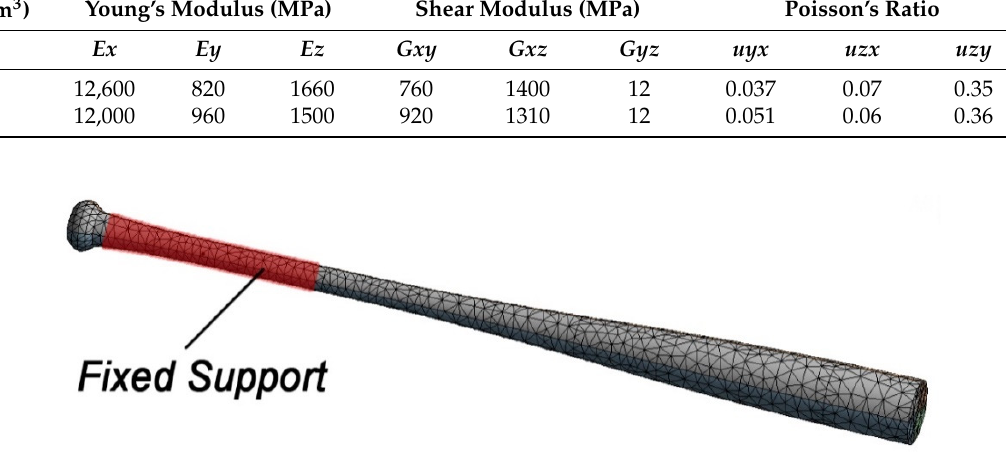
Figure 4. Boundary conditions on the handle of a baseball bat. Table 1. Mechanical properties of sugar maple ( Acer saccharum Marshall) and white ash ( Fraxinus americana L.) [36].